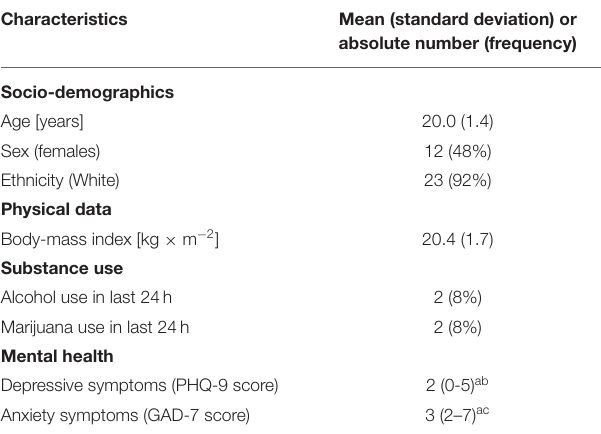
TABLE 1 | Basal characteristics of study